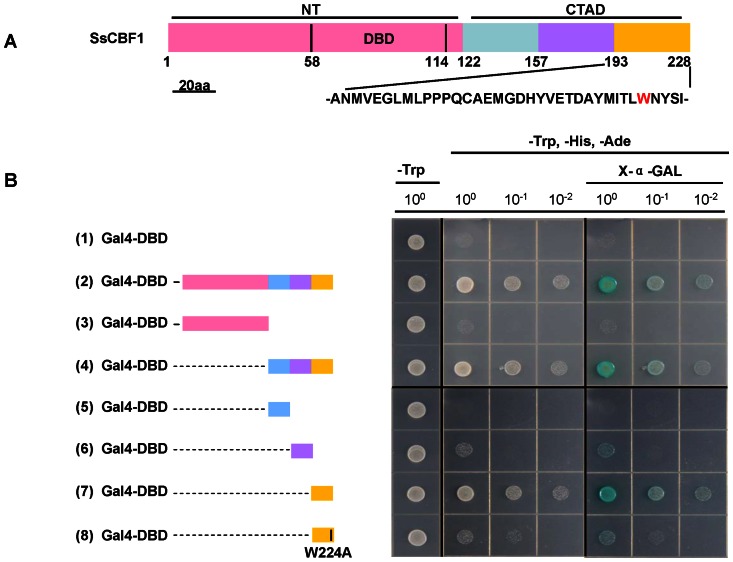
Functional dissection of the SsCBF1 C-terminal activation domain in yeast.(A) Schematic protein structure of SsCBF1. Full-length SsCBF1 and its derivatives (SsCBF10–121, SsCBF1122–156, SsCBF1157–192, and SsCBF1193–228) were tested for the transactivation activity (see Methods for details). SsCBF1 derivatives were symbolized by filled color boxes. NT, N-terminal; CTAD, C-terminal activation domain; DBD, DNA-binding domain. Bar  = 20 amino acids (aa). (B) Mapping the putative transcriptional activation domain of SsCBF1 in yeast. Based on the schematic protein structure of SsCBF1, SsCBF1 and its derivatives including the mutant version of SsCBF1193–228(W224A) were fused to the Gal4-DBD (pGBKT7). The empty pGBKT7 vector was used as a negative control. Survival of yeast cells on the selective media needs the presence of functional activator peptides. X-a-Gal was used to test the expression of α-galactosidase.